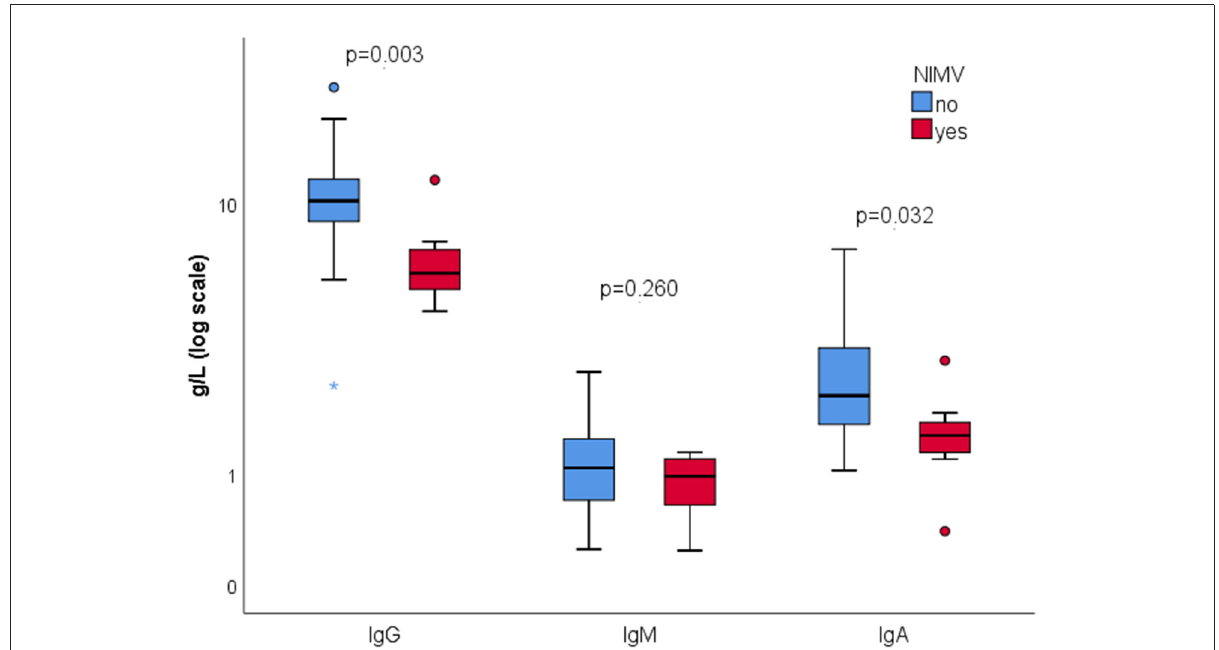
FIGURE1 Total serum immunoglobulins concentration according to the use of NIMV (log scale).